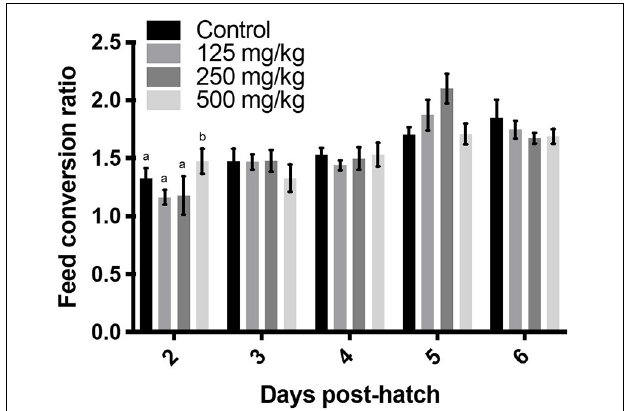
FIGURE 4 | Daily feed conversion ratio over 6 days. Values represent least squares means ± SEM ( n = 12–13). Different superscripts within each day indicate a significant difference at P < 0.05; Tukey’s test.